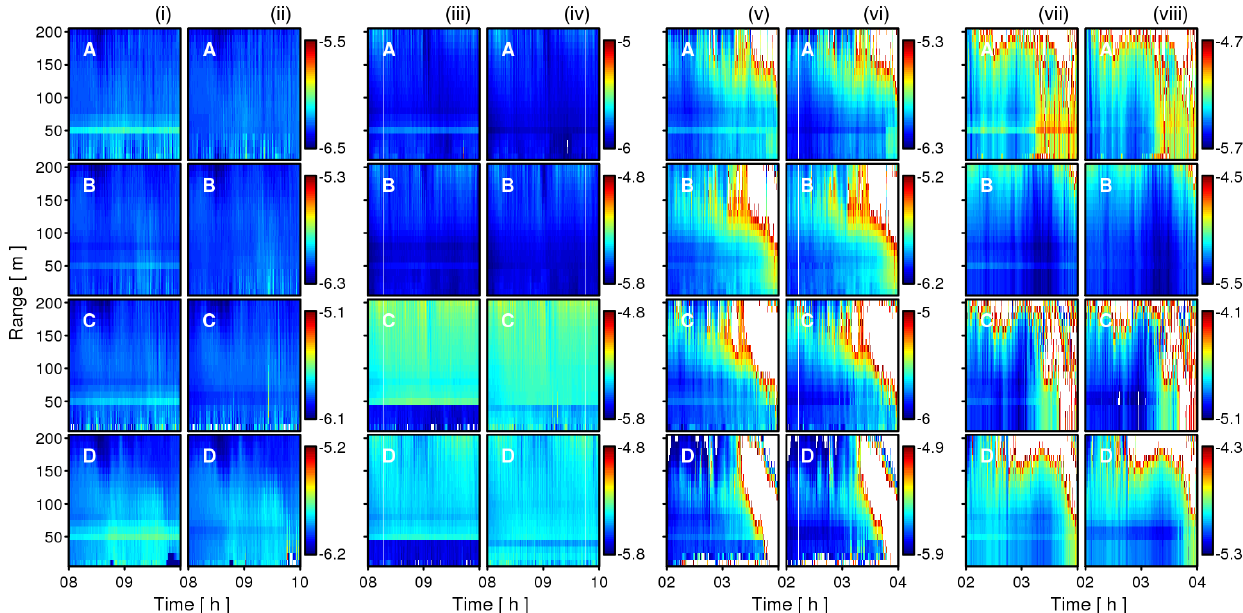
Figure 7. Observations from four Vaisala CL31 ceilometers from the LUMO network (Table 2) over the first 200m range: (i, iii, v, vii) logarithm of the range-corrected signal reported RCS (a.u.); (ii, iv, vi, viii) as in (i, iii, v, vii) but after application of correction for near-range artefacts associated with the obstruction correction and a hardware-related perturbation (see Fig. 6). Sensors were operating with firmware 1.61 (A, B) and 2.01 (C, D) on (i, ii) 10 January 2014, (iii, iv) 15 January 2014, (v, vi) 6 January 2013, and firmware 1.72 and 2.03 on (vii, viii) 13 March 2016. White areas indicate values outside of the range of values selected (see colour legends). Note that data are not absolutely